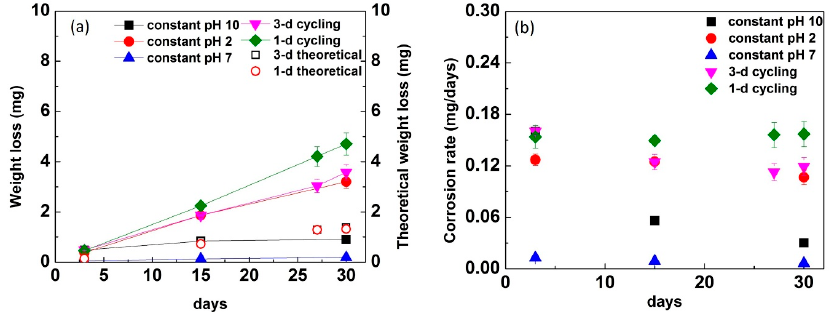
Figure 1. The ( a ) weight loss and ( b ) corrosion rate of constant immersion in pH 10, pH 2, and pH 7 at 3-d cycling and 1-d cycling for 3 days, 15 days, and 30 days. The theoretical weight loss for 3-d cycling and 1-d cycling is also shown.